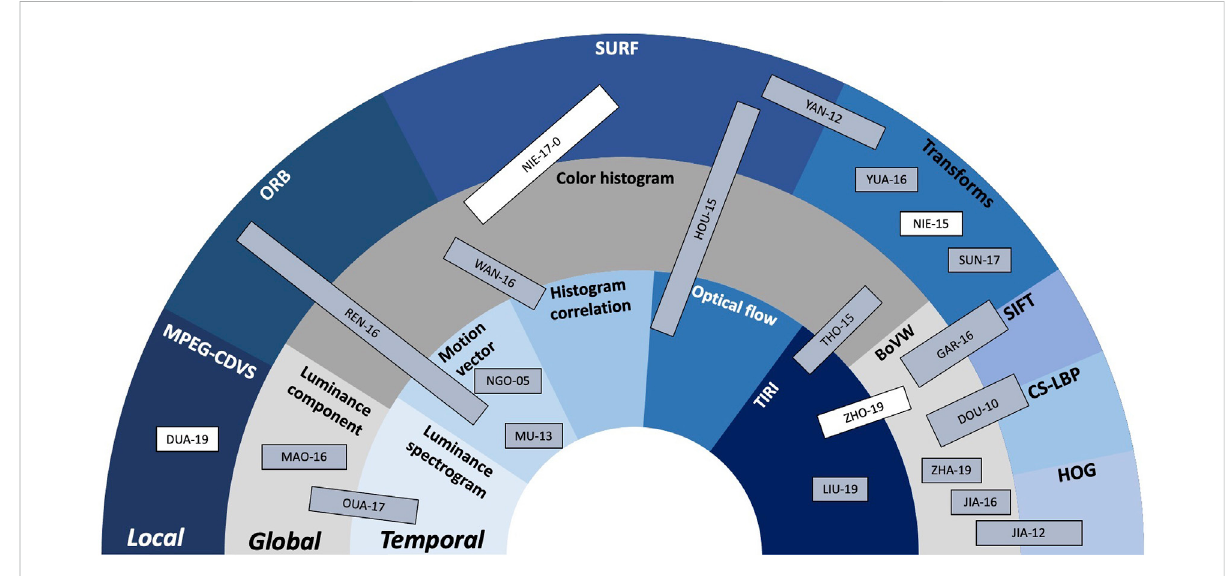
FIGURE 5 Conventional fi ngerprintingmethod synopsis: thehemicycles(areas)relatedtothelocal,global,andtemporalfeaturesarelocated attheouter, middle, and inner parts of the fi gure, respectively. Inside each hemicycle, examples of state-of-the-art solutions are presented. Conventional methods are presented in gray-shadowed rectangles while NN-based methods that also include conventional modules are represented in white